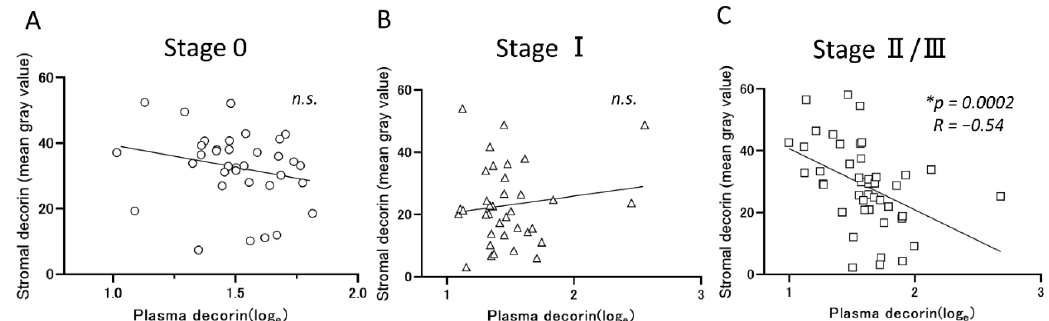
Figure 2. The plasma levels of decorin were negatively correlated with stromal decorin expression in the patients with advanced ‐ stage cancer. ( A – C ): The correlation between stromal and plasma decorin was analyzed in patients with Stage 0 ( A ), Stage I ( B ), and Stage II and III ( C ) breast cancer. Data were analyzed using Spearman’s rank correlation and * indicated statistically significance.